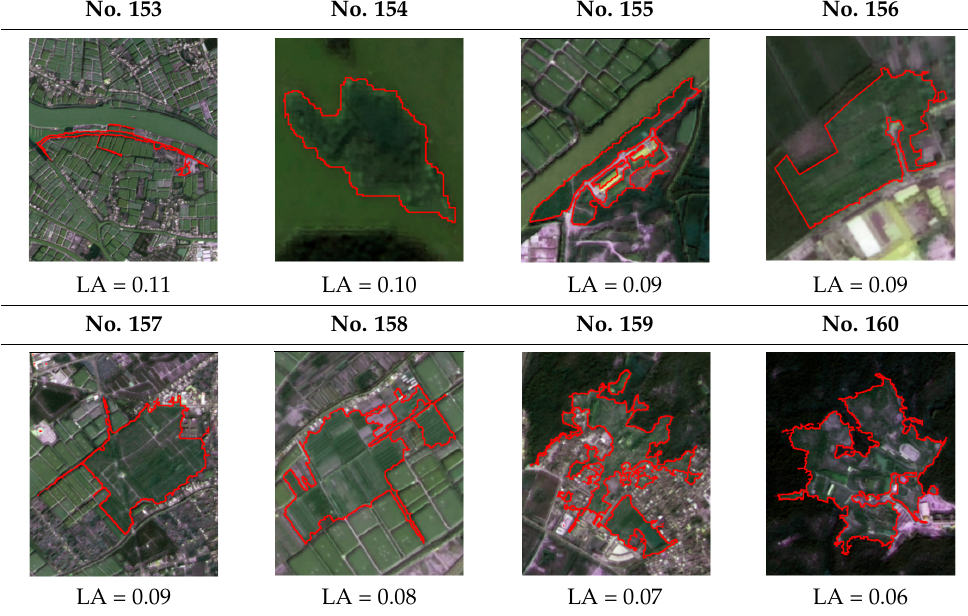
Figure 16. The landscape activity map.